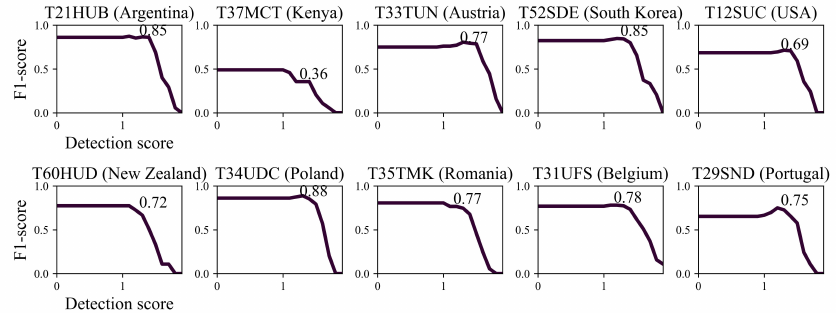
Figure 8. Box validation F 1 scores by detection score threshold.